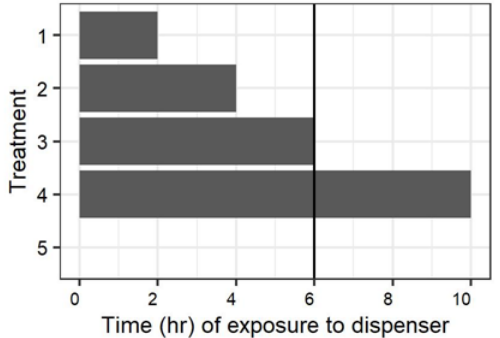
Figure 1. Mating disruption treatment regimens for experiments in 208 L chambers. Males were introduced into the chamber at the beginning of a 10 h scotophase, and females were introduced after six hours (vertical line). The first three treatments involved exposure to mating disruption dispensers inside the arena for the first two, four, or six hours before withdrawing the dispenser. The fourth and fifth treatment were respectively mating disruption dispensers left throughout the scotoperiod (including after the females were introduced), and no mating disruption dispenser in the arena at any time.